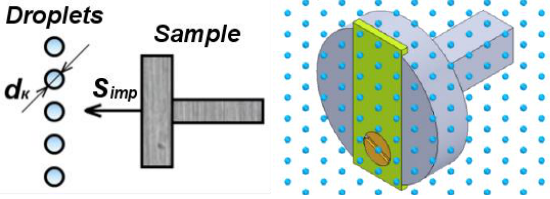
Figure 6. Scheme of sample interaction with liquid droplet flow.